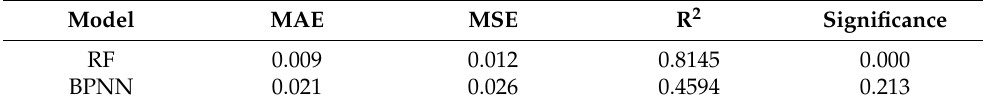
Table 6. Error analysis of assessment results.